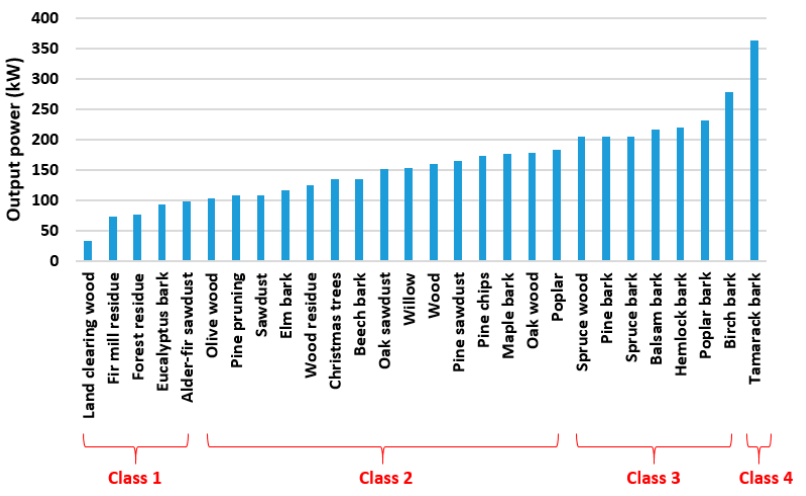
Figure 3. Net output power from 28 WB&FR gasification systems.